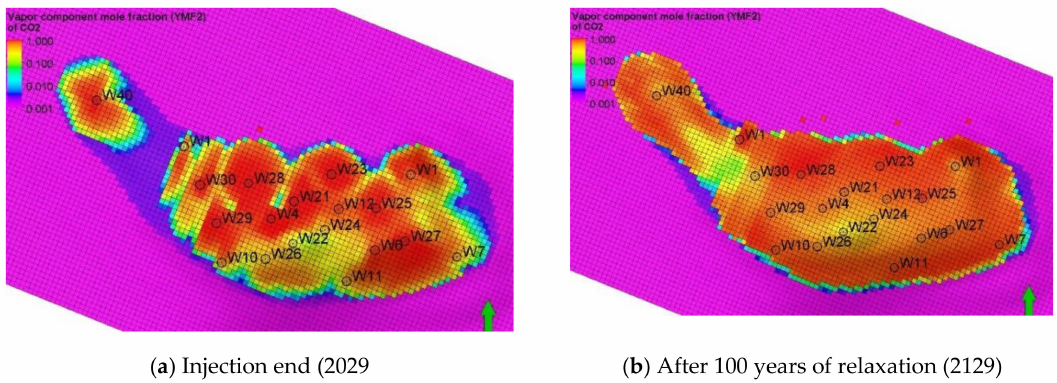
Figure 47. Distribution of CO 2 concentration in the gas phase at the structure top.